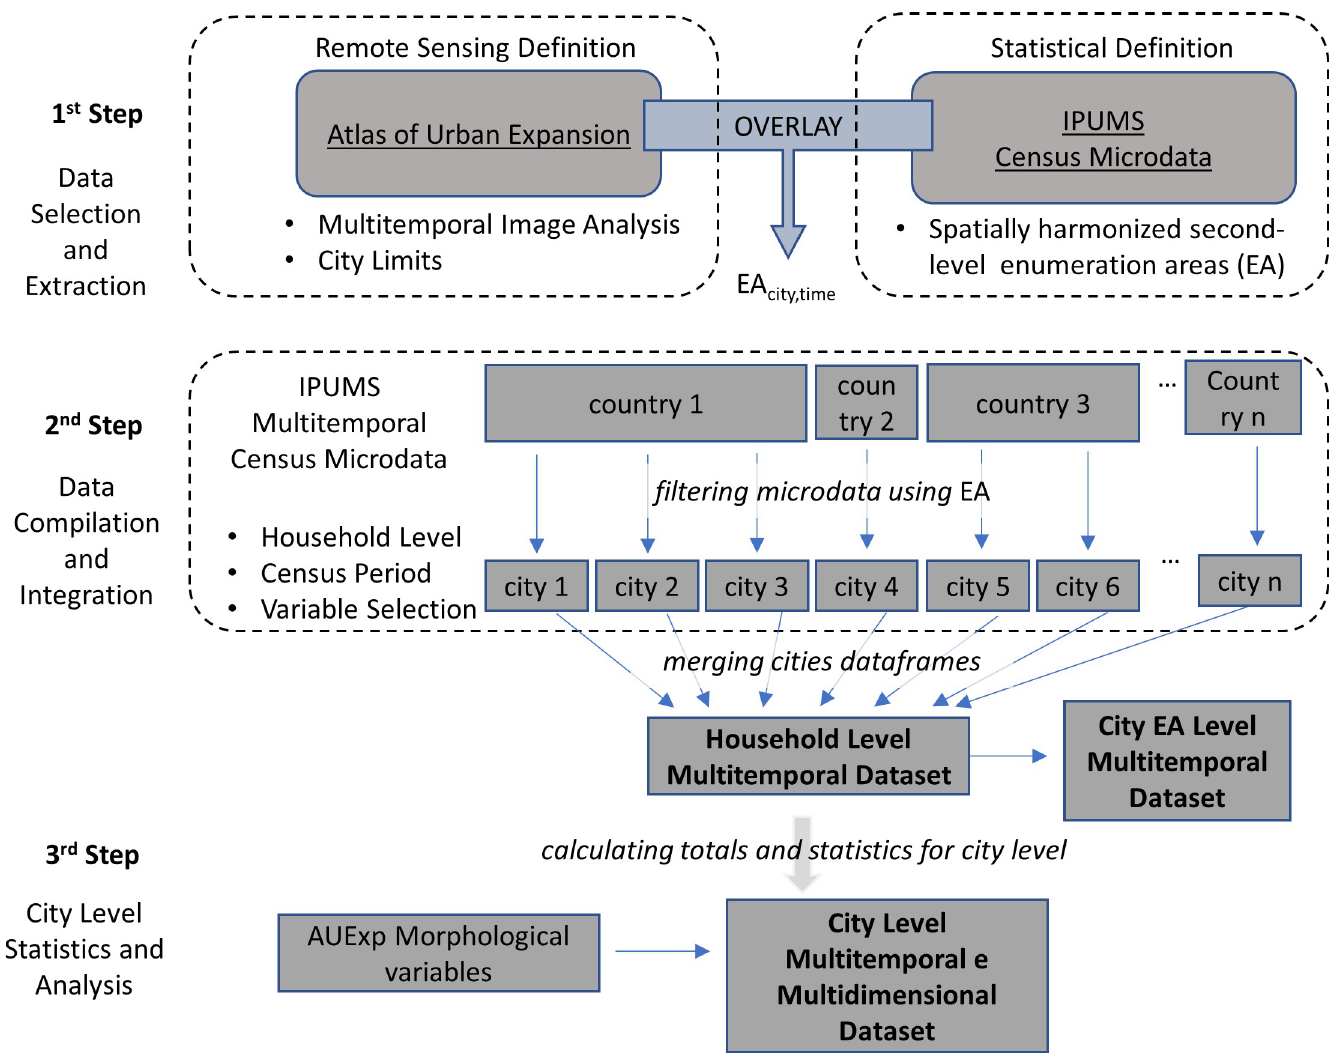
Fig 2. Schematic DUIA’s workflow.